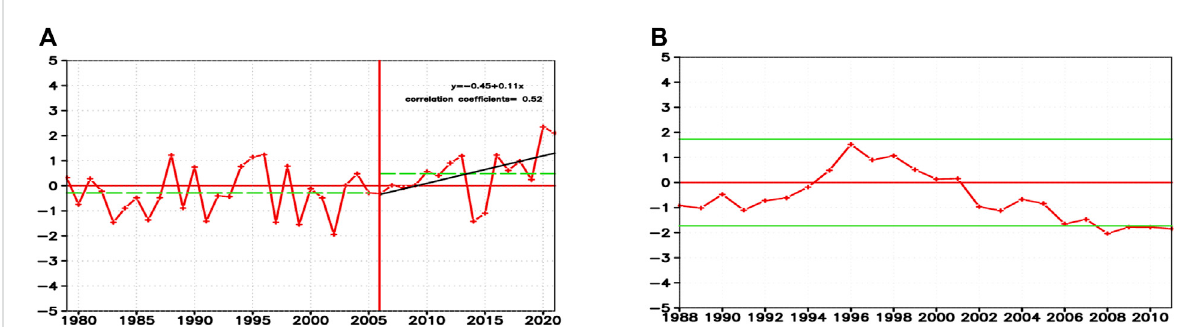
FIGURE 2 (A) NormalizedtimeseriesofSRNCindexduring1979 – 2021.Thehorizontaldashlinesindicatethemeanduringtwoperiods,thesolidblackline during2006 – 2021indicatesthelineartrend,andtheverticallineindicatestheinterdecadalabruptchangeyear. (B) A20-yearrunning t -testofSRNC index, with two green lines showing a 95% con fi dence level.